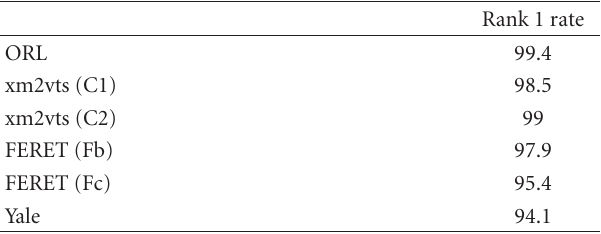
Table 3: The results of 4-component size 20 × 20 for the new method.